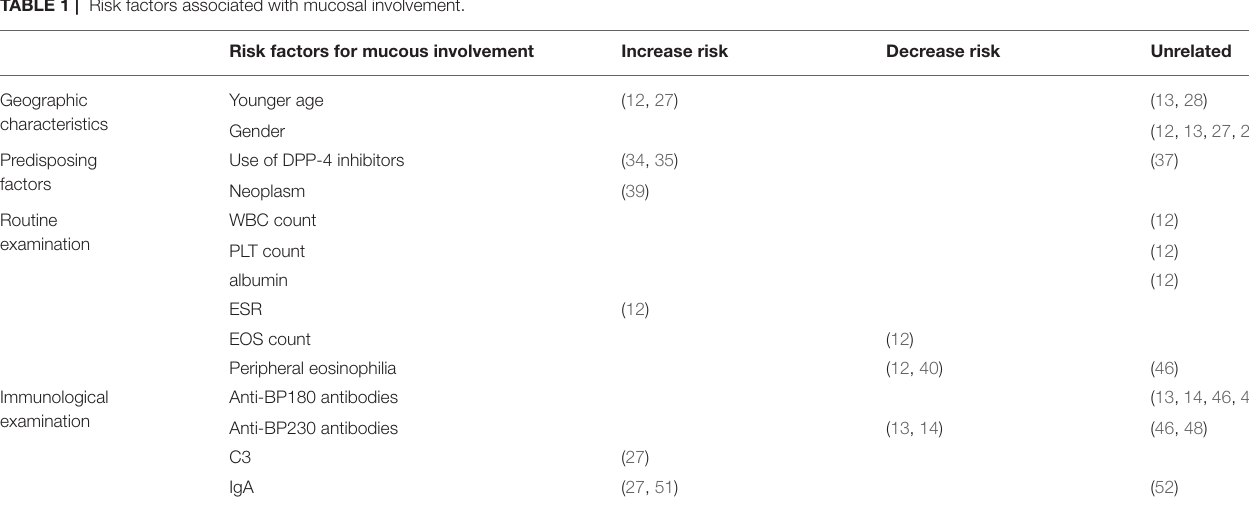
FIGURE 1 | Factors that may influence mucosal involvement. EOS, eosinophil; PLT, platelet; WBC, white blood cell; ESR, erythrocyte sedimentation rate. TABLE 1 | Risk factors associated with mucosal